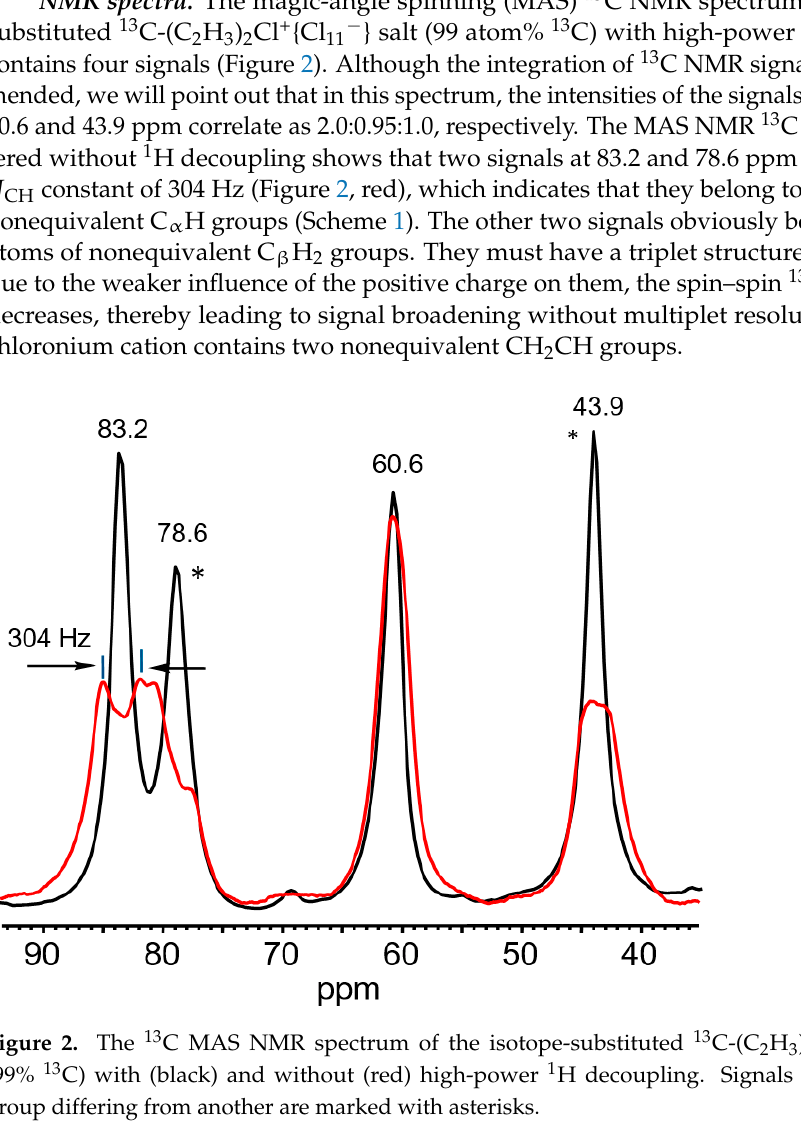
Figure 2. The 13 C MAS NMR spectrum of the isotope ‐ substituted 13 C ‐ (C 2 H 3 ) 2 Cl + {Cl 11 − } salt (99% 13 C) with (black) and without (red) high ‐ power 1 H decoupling. Signals of the one vinyl group differing from another are marked with asterisks.